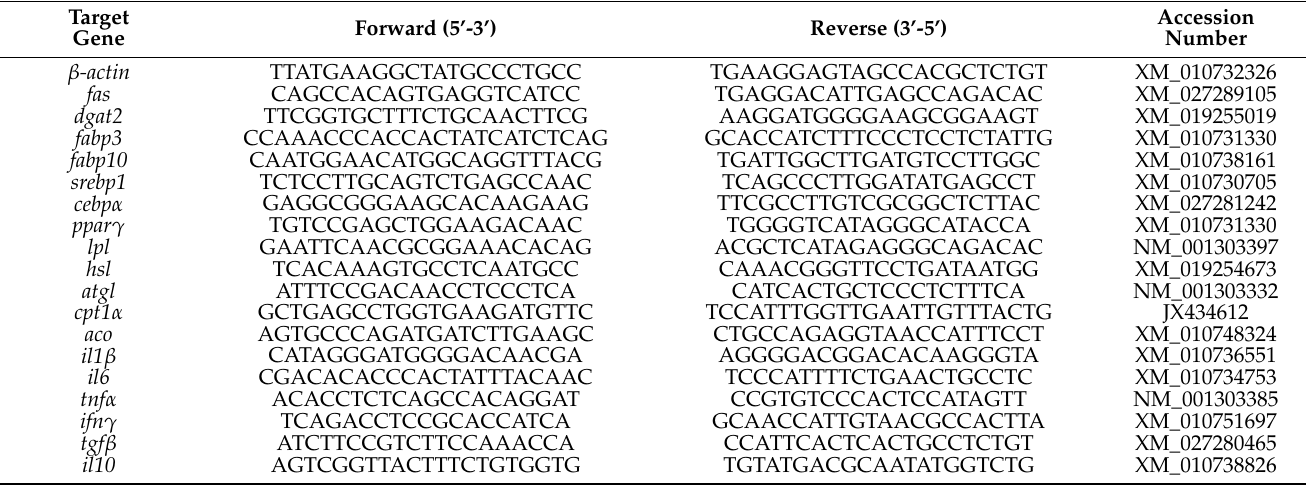
Table 3. Primers used for RT-qPCR and genes’ accession